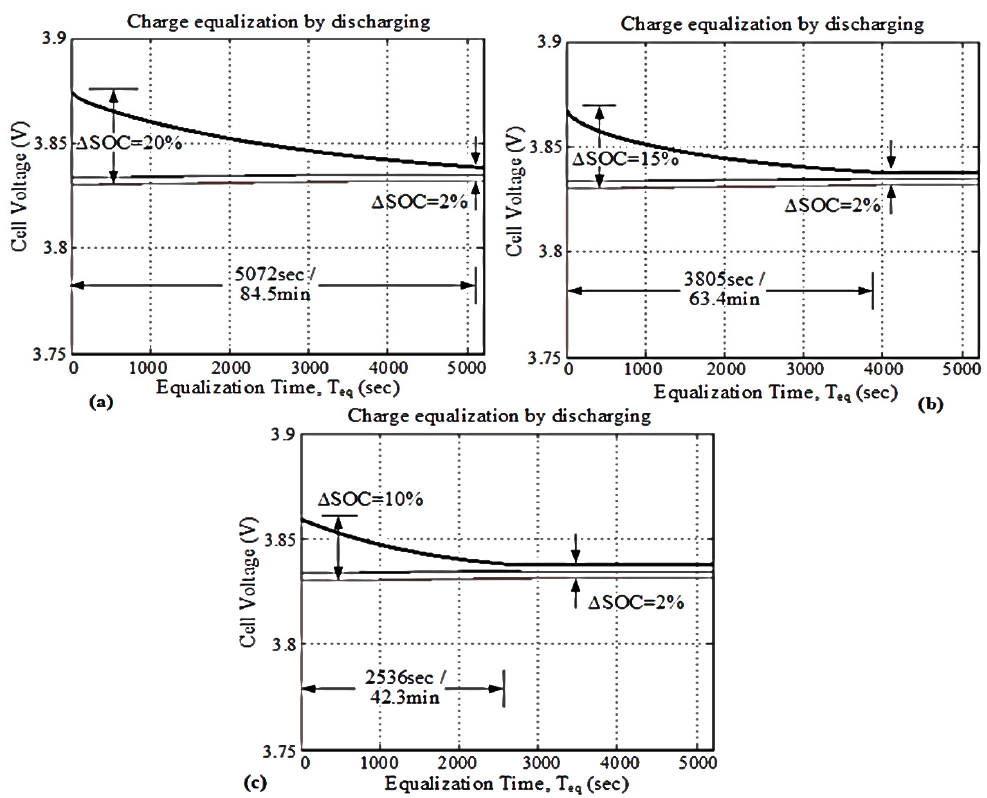
Figure 13. Battery charge equalization performance ( a ) discharge with 20% SOC difference; ( b ) discharge with 15% SOC difference; and ( c ) discharge with 10% SOC difference.